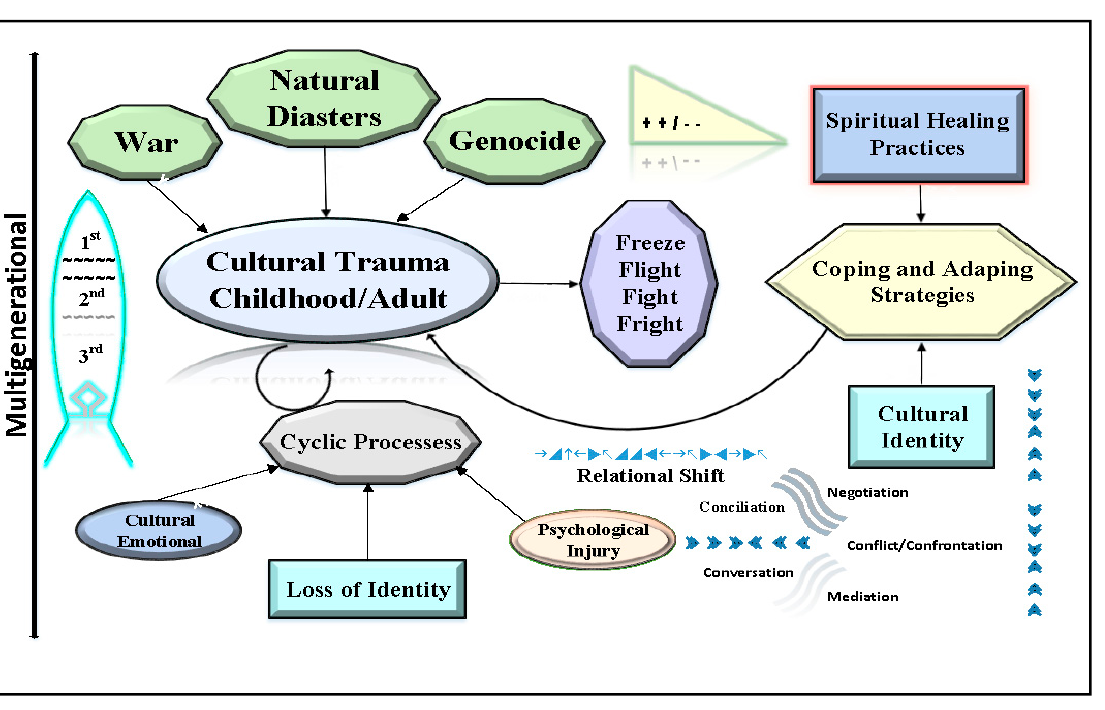
Figure 1. Conceptual Framework for Trauma. Trauma, manifested as freeze, flight, fight, fright, is a complex multigenerational process that juxtaposes conflict/confrontation (war, natural